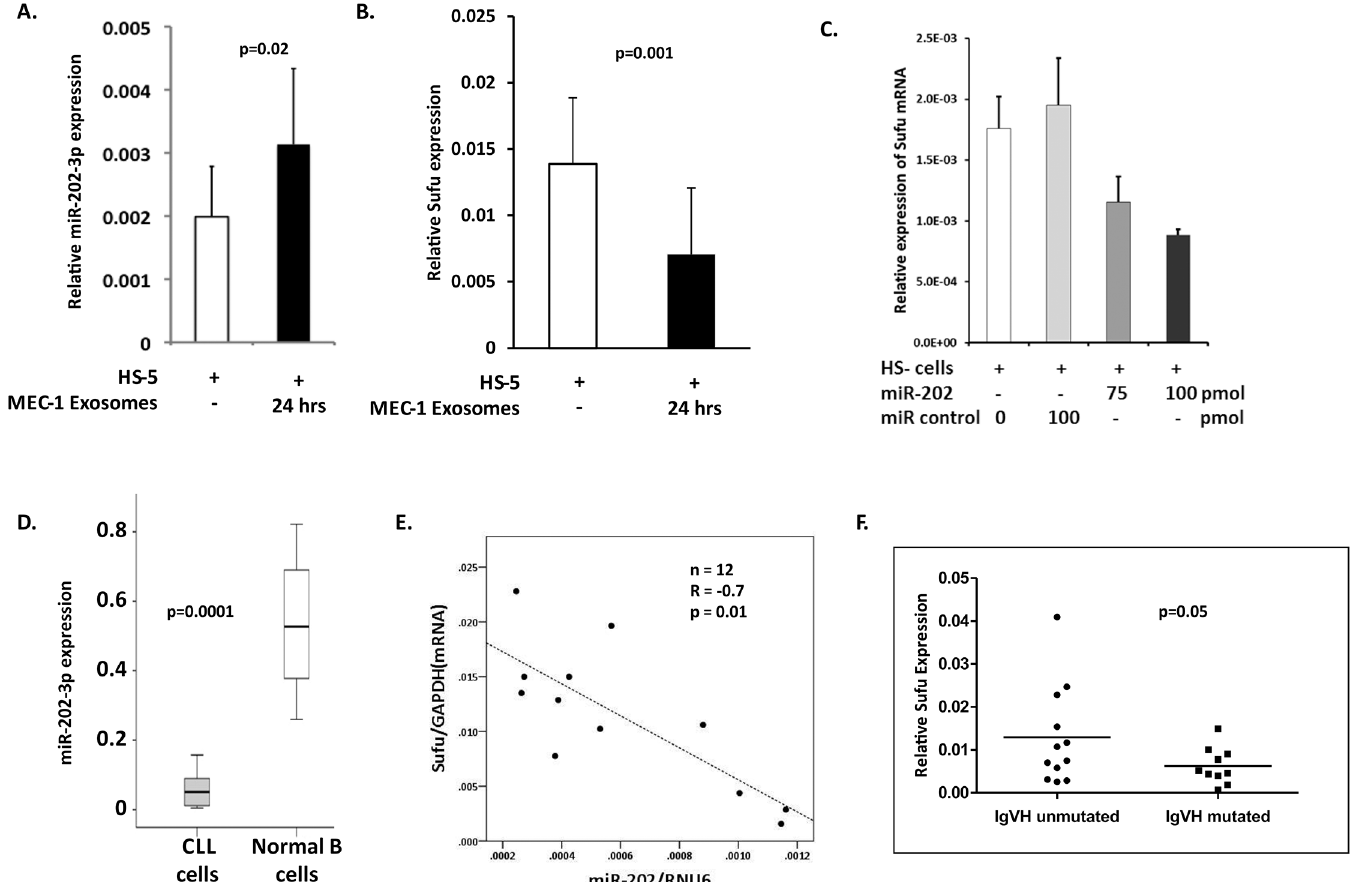
Fig 5. Expression of miR-202-3p and its target Sufu mRNA in CLL cells. (A) HS-5 cells incubated with MEC-1 exosomes for 24 hrs show increased expression of miR-202-3p by RT-qPCR analysis. The results represent the findings of three independent experiments. (B) HS-5 cells incubated with MEC-1 exosomes for 24 hrs show decreased expression of Sufu, one of the miR-202-3p targets, by RT-qPCR analysis. The bar graphs are derived from three independent experiments. (C) RNA extracted from HS-5 cells transfected overnight with a synthetic miR-202-3p mimic or scrambled control, was subjected to RT-qPCR to assess Sufu mRNA expression. (D) RT-qPCR of miR-202-3p, using RNA prepared from CLL cells (n = 19) or normal B cells (n = 4). Box plots show the expression level of miR-202-3p relative to a miR-U6B control for normalisation. (E) Primary CLL cell lysates (n = 12) were subjected to RT-qPCR analysis for miR-202-3p and Sufu mRNA expression levels, normalised to RNU6 and GAPDH expression respectively, and show statistically significant inverse correlation. Plotted data represent mean of experiments performed in triplicate. (F) Sufu mRNA expression, using RT-qPCR and GAPDH as reference, in primary CLL cells of 12 unmutated and 10 mutated CLL cases is shown. Data demonstrate relatively higher (p = 0.05) levels of Sufu expression in the IgVH unmutated cohort. The expression in individual cases represents the mean of triplicate